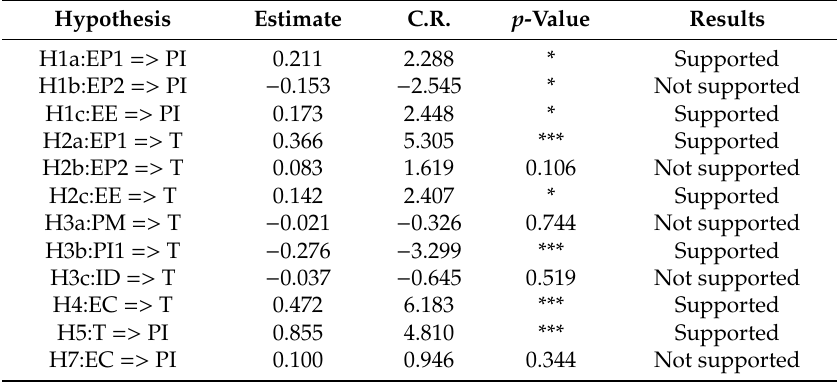
Table 5. Structural model relationships obtained.